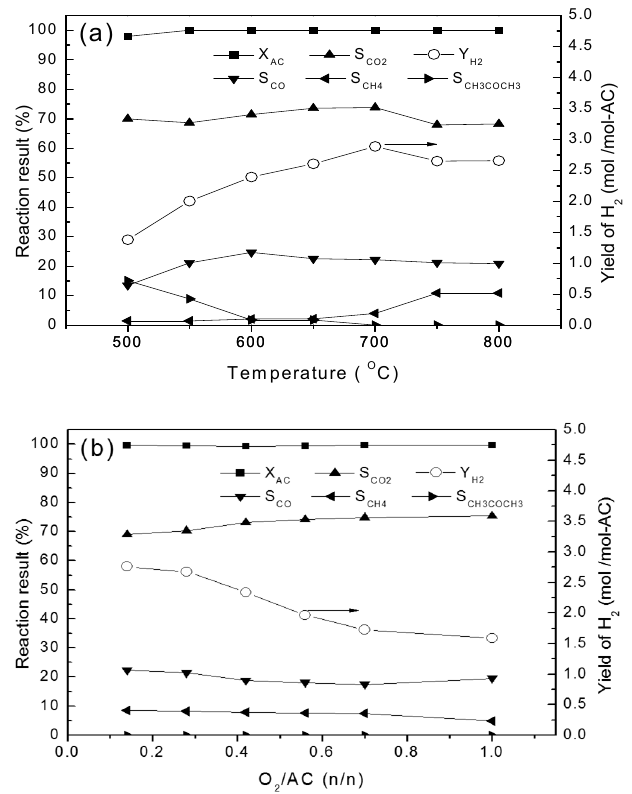
Figure 2. ( a ) Effect of temperature on the catalytic performance of MNC 0.5 F 0.3 in ATR of AC at 3.6 g ‐ AC/(g ‐ catalyst.h) and 1 atm; ( b ) effect of O 2 /AC on the catalytic performance of MNC 0.5 F 0.3 in ATR at